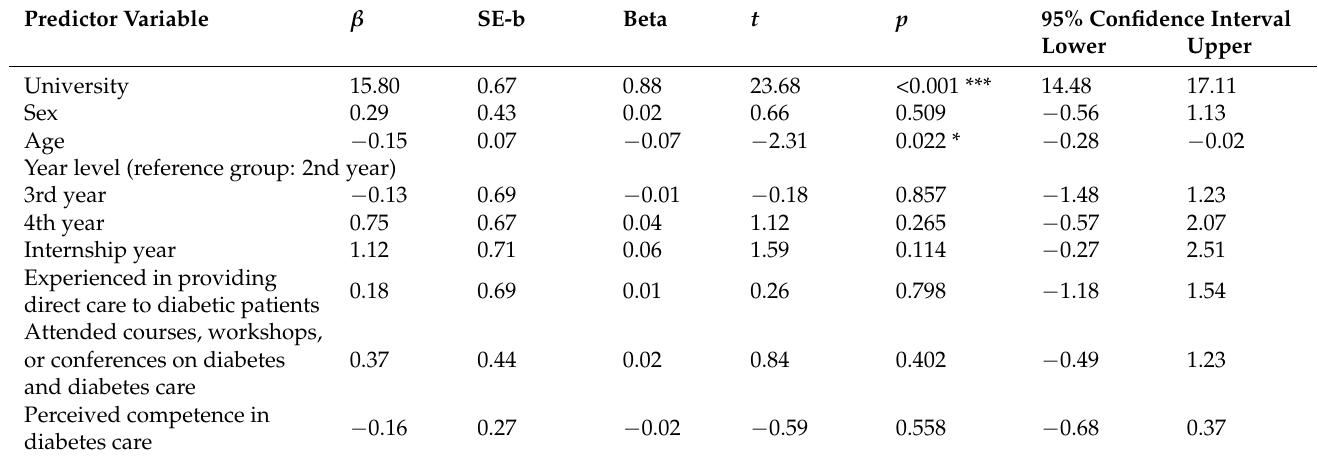
Table 5. Results of the multiple regression analysis to identify the predictors of actual knowledge ( n =